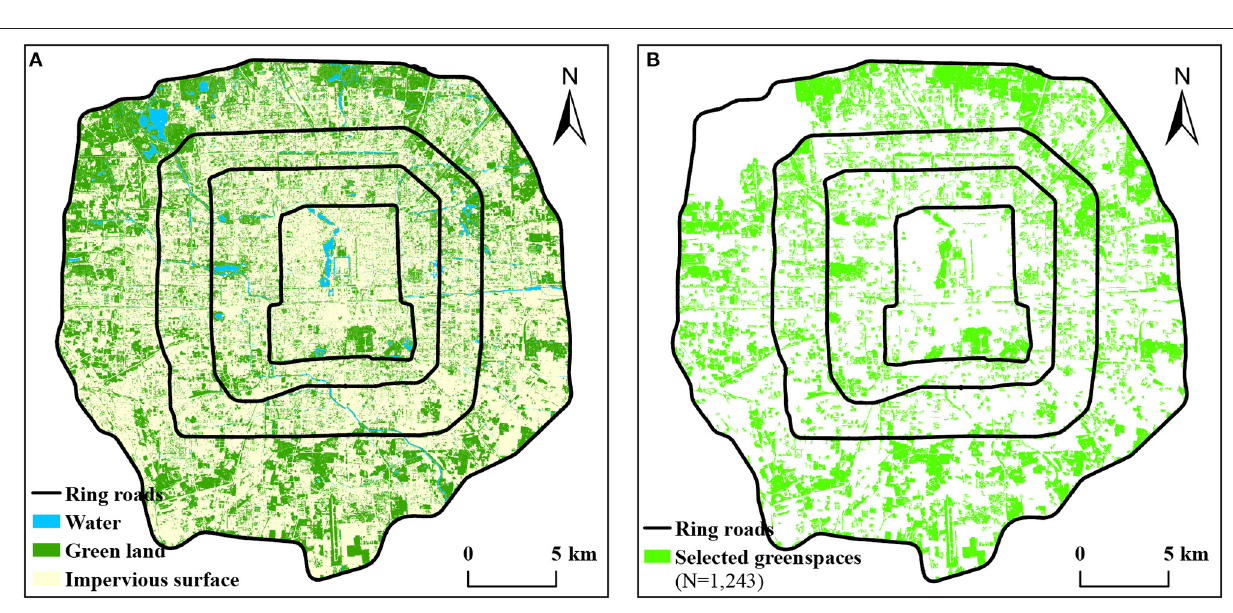
FIGURE 3 | Spatial distribution of land use in the study area (A) , green spaces selected as the study objects (B)